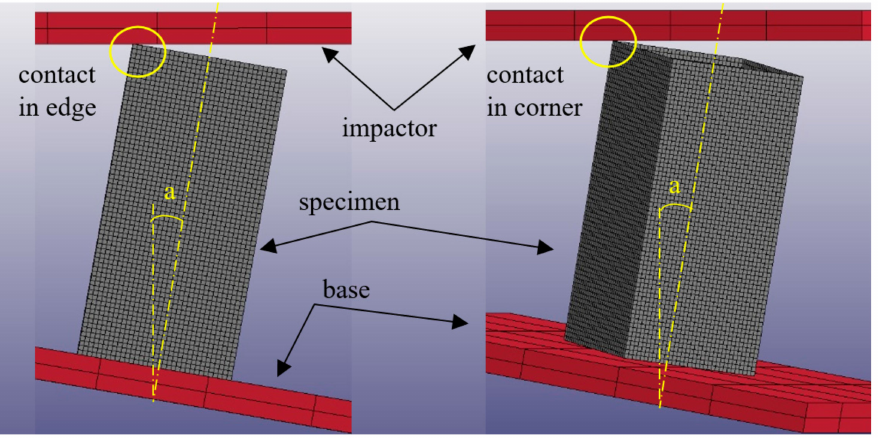
Figure 4. FE models for oblique impact loading under an edged ( left ) and a cornered ( right ) initial